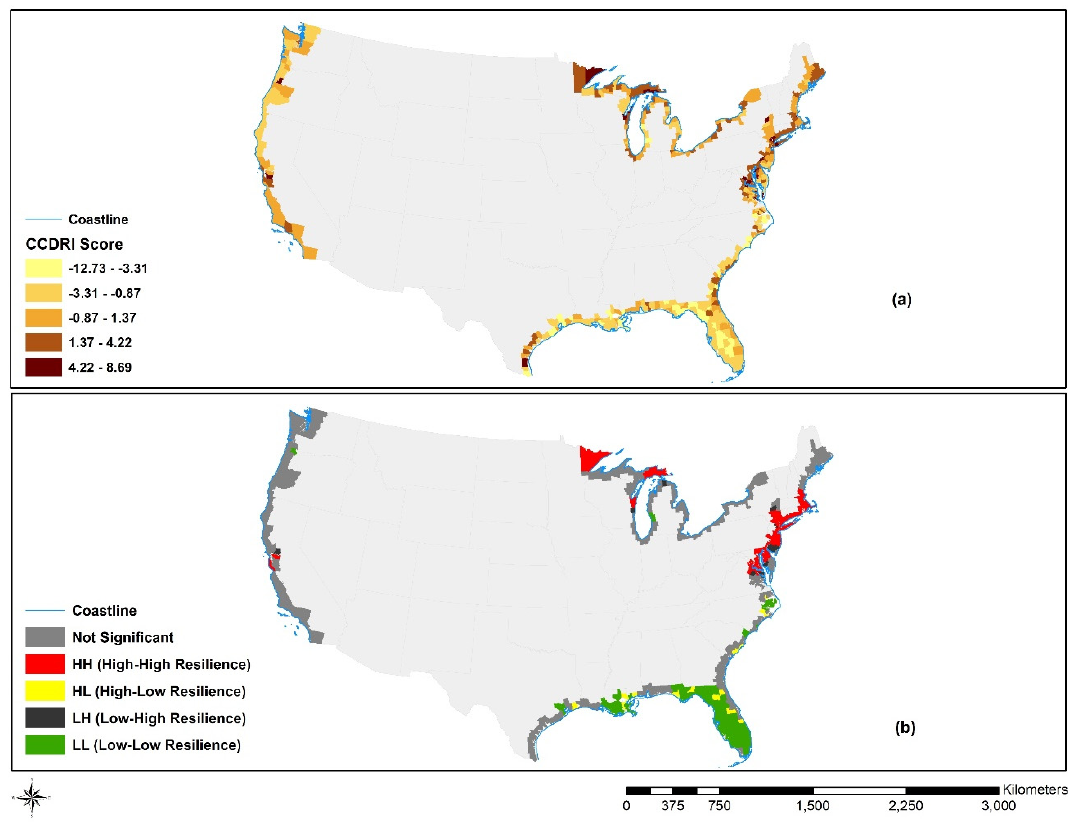
Figure 2. The spatial distribution of ( a ) composite community disaster resilience index (CCDRI) scores and ( b ) clusters of hot and cold spots of CCDRI